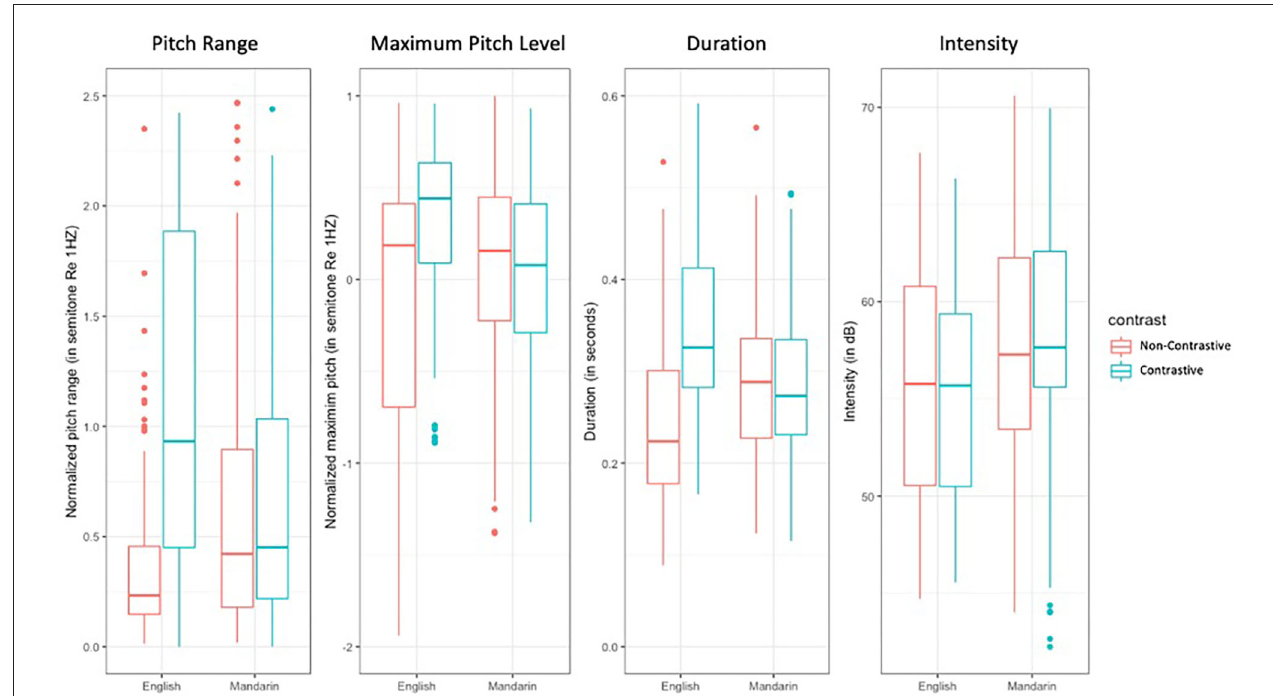
FIGURE 1 | Speech production of L1 English and Mandarin-English L2 Speakers contrastive and non-contrastive stress.